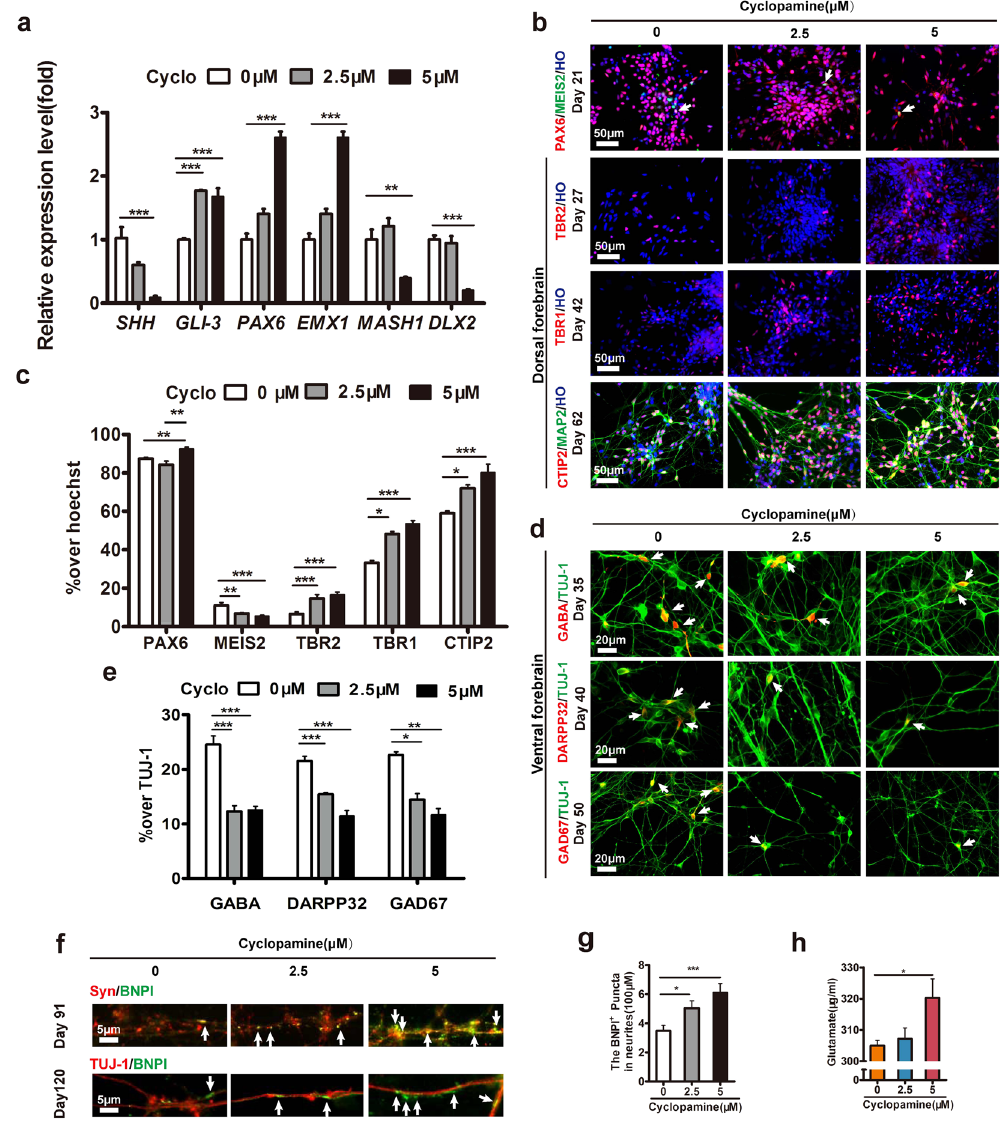
Figure 1. Specification of enriched glutamatergic neurons from hESCs under the high concentration of cyclopamine. ( a ) Fold change of the specific mRNA levels of the SHH , GLI-3 , dorsal forebrain ( PAX6 , EMX1 ) and ventral forebrain ( MASH1 , DLX2 ) at d17. ** p < 0.01; *** p < 0.001. n = 3 in each condition. ( b ) Expression of the regionalization markers of the dorsal forebrain (PAX6, TBR2, TBR1, CTIP2), ventral forebrain (MEIS2) from d21 to d62. The arrows indicate the LGE cells co-expressed PAX6 with MEIS2. Scale bar, 50 μ m. ( c ) Percentage of the total cells expressing neuronal regionalization markers from d21 of differentiation. * p < 0.05; ** p < 0.01; *** p < 0.001. More than 1,500 cells from random fields were manually counted in each condition. The data are presented as the mean ± s.e.m, n ≥ 3 in each condition. ( d ) Expression of the GABAergic neurons related markers GABA (arrows), DARPP32 (arrows), GAD67 (arrows) from d35. Scale bar, 20 μ m. ( e ) Quantification of the GABAergic neurons related markers GABA, DARPP32, and GAD67 in total number of neurons. * p < 0.05; ** p < 0.01; *** p < 0.001. More than 500 neurons from random fields were manually counted in each condition. The data are presented as the mean ± s.e.m, n ≥ 3 in each condition. ( f ) After d91, BNPI + (arrows) puncta were clearly observed in TUJ-1 + neurites and co-localized with synaptophysin + puncta. Scale bar, 5 μ m. ( g ) The density of BNPI + puncta in TUJ-1 + neurites. * p < 0.05, *** p < 0.001. More than 38,800 μ m of TUJ-1 + neurites from random fields were manually counted in each condition. The data are presented as the mean ± s.e.m, n = 3 in each condition. ( h ) Glutamate Assay Kit was performed to detect the concentration of glutamate after d180 of differentiation. * p < 0.05. The data are presented as the mean ± s.e.m, n = 3 in each